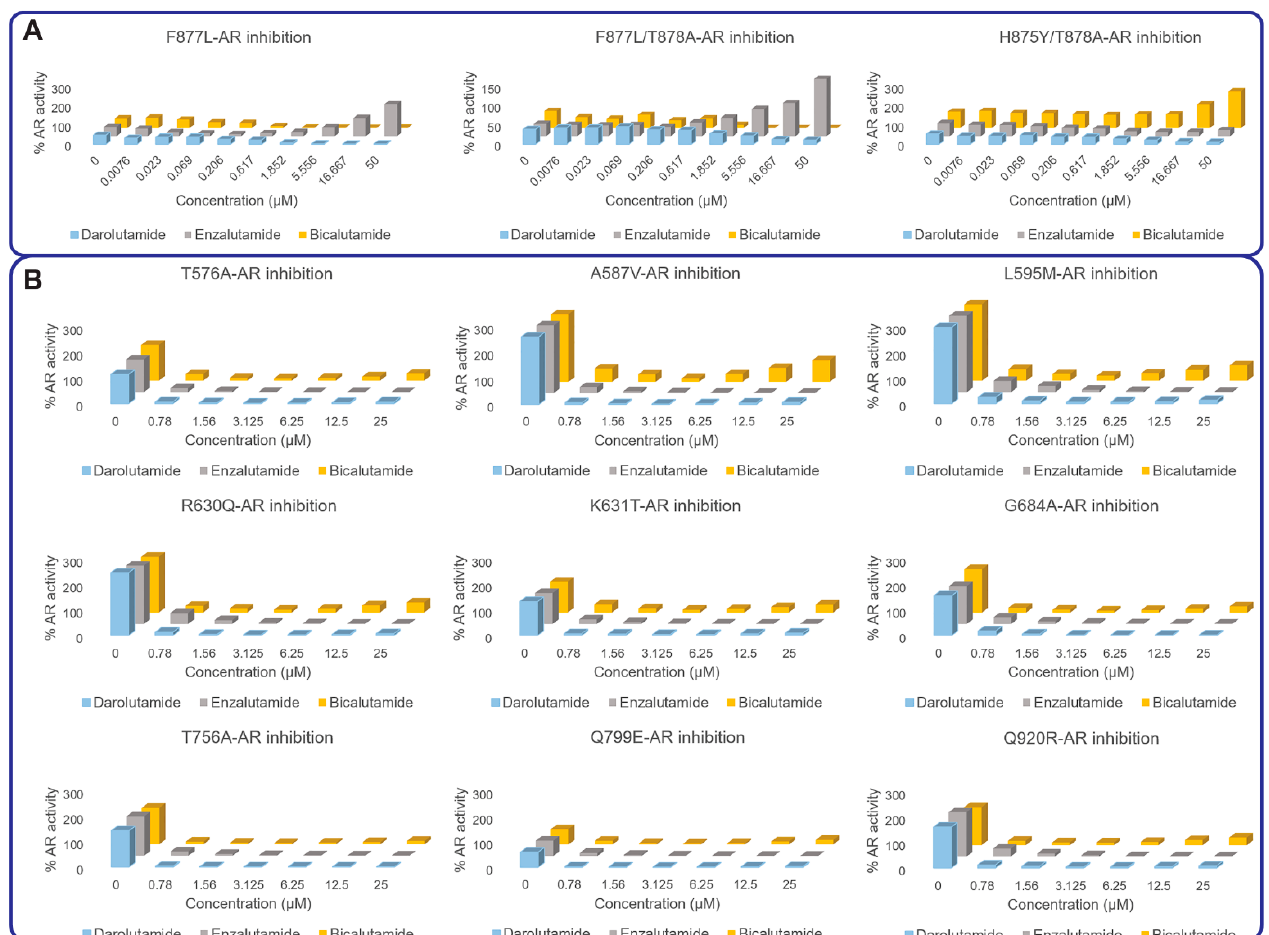
Figure 3. AR mutants showing partial or full agonist response in presence of high concentrations of AR antagonists. ( A ) Previously characterized AR mutants activated by enzalutamide or bicalutamide treatment. ( B ) Newly characterized AR mutants showing signs of activation in presence of bicalutamide. Each concentration was assayed in quadruplicate, n = 4, with a biological replicate of n = 3. Results were averaged and normalized by expressing them as a percentage of WT-AR activity.